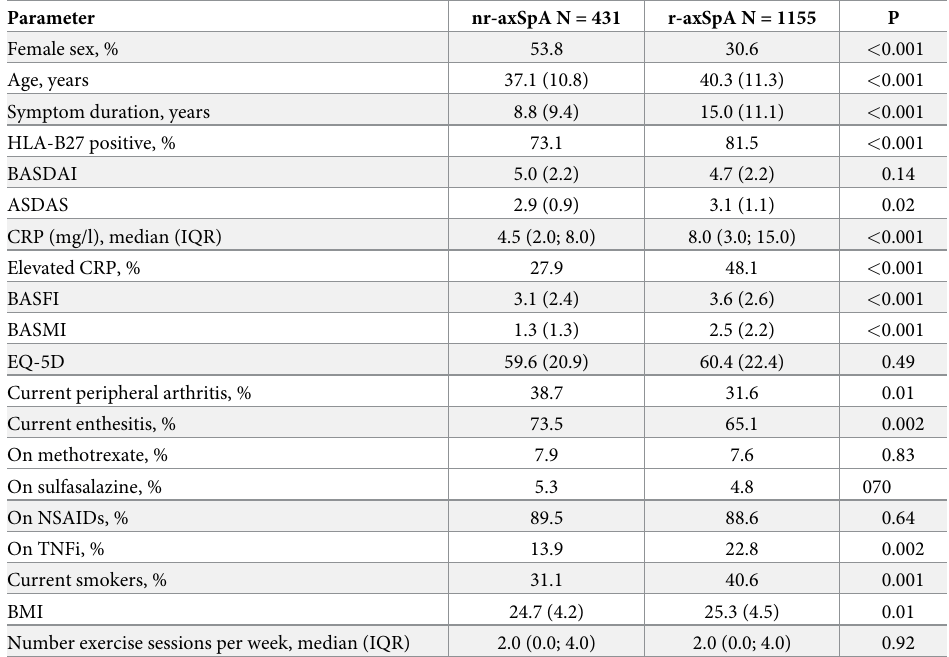
Table 2. Baseline characteristics of all patients with r-axSpA and nr-axSpA at recruitment in SCQM. Parameter nr-axSpA N = 431 r-axSpA N = 1155 P Female sex, % 53.8 30.6 < 0.001 Age, years Symptom duration, years